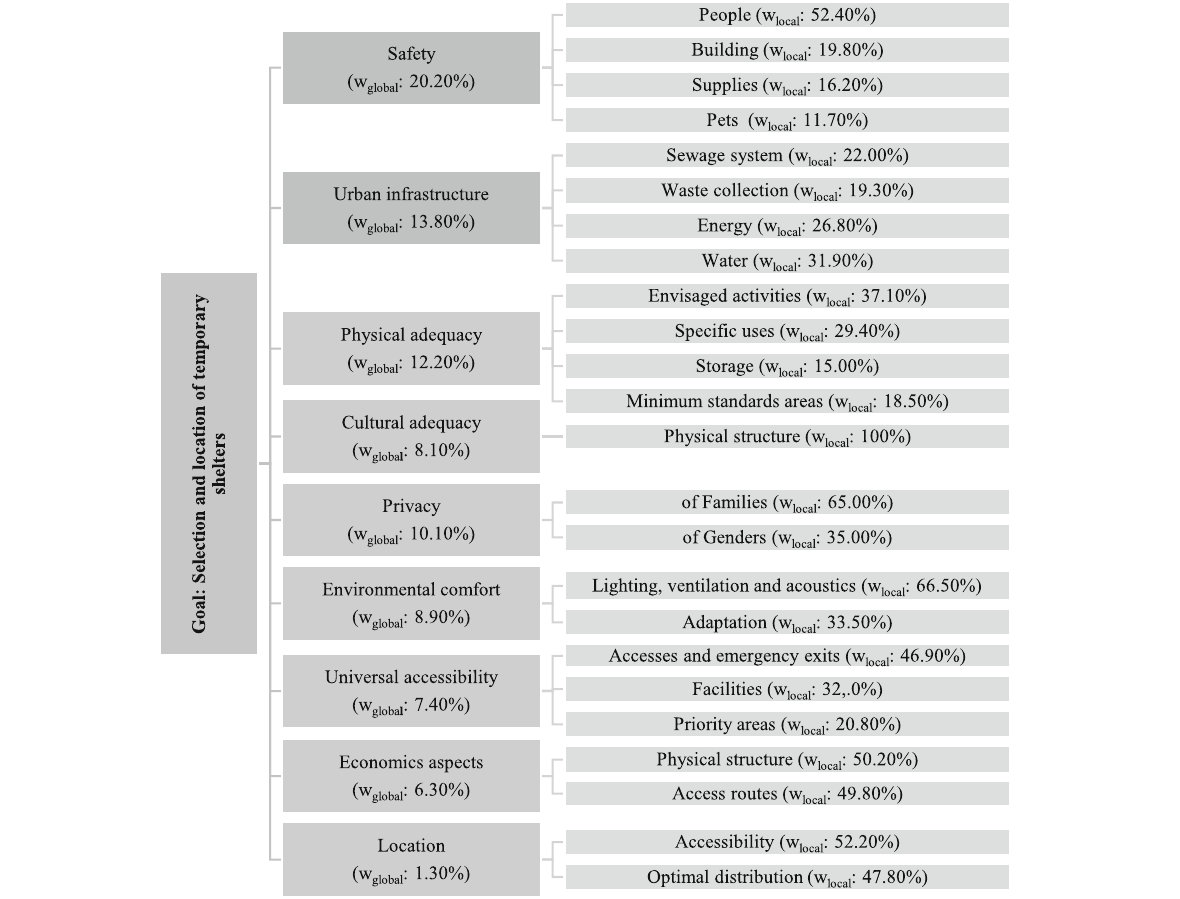
Fig. 3. Final hierarchical tree representation showing the global and local criteria with weights (w global : global weight, w local : local